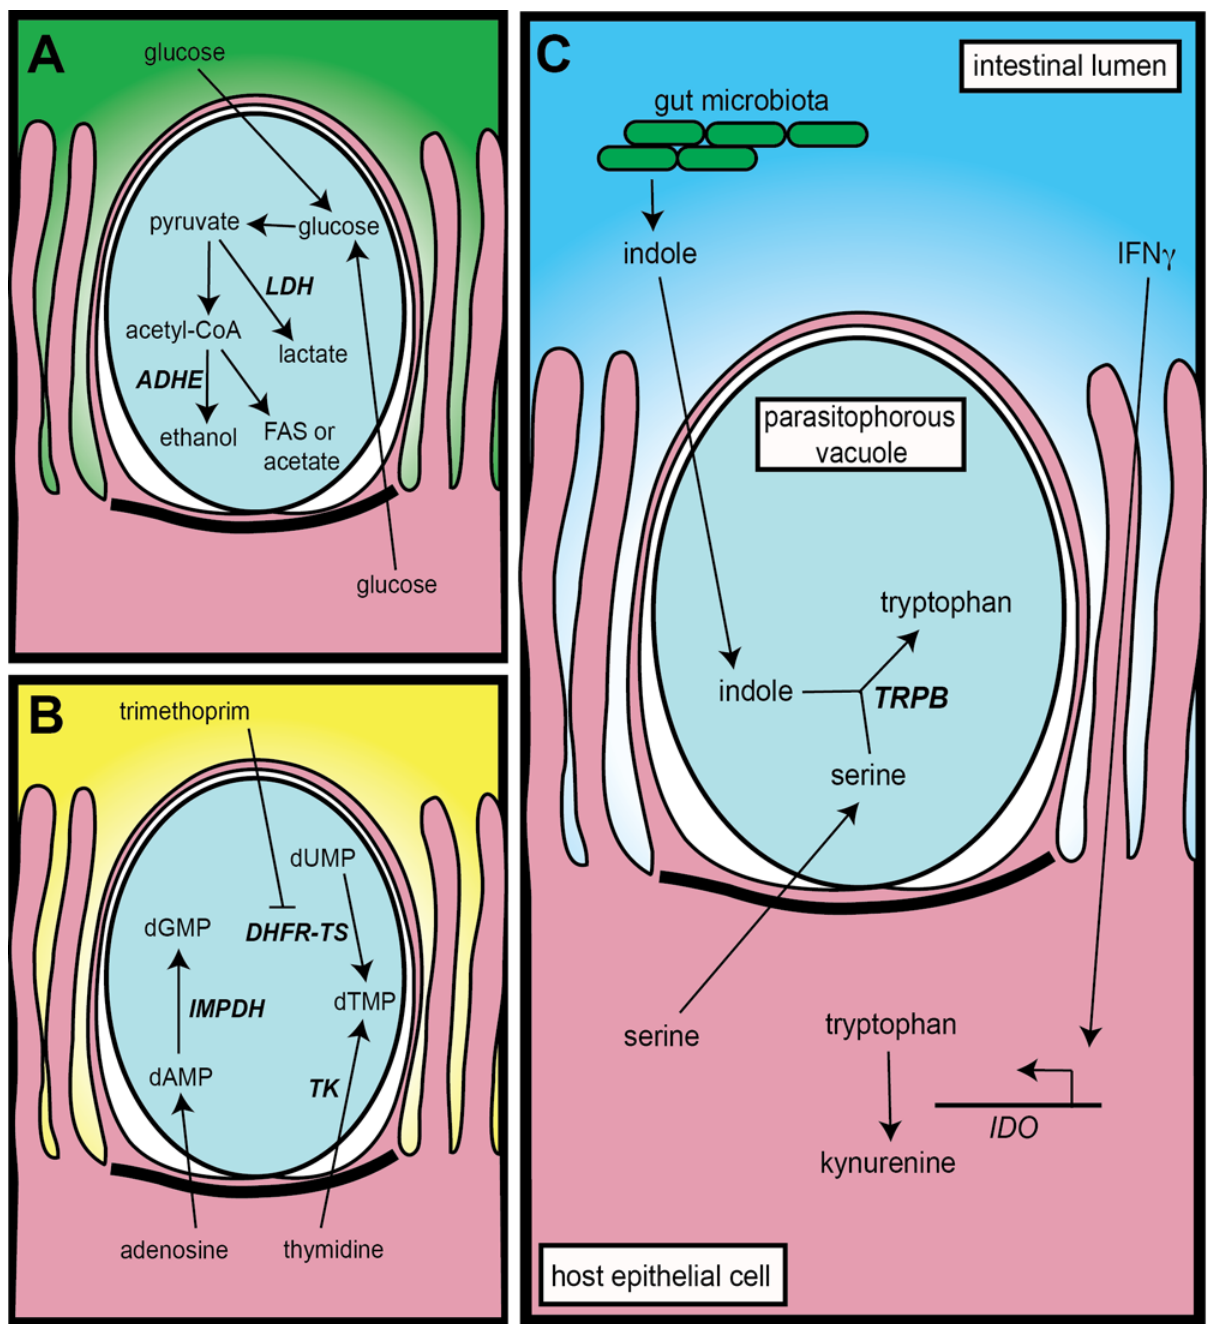
Fig 1. Horizontally transferred genes and their proposed functions in Cryptosporidium biology. A. Anaerobic metabolism . Cryptosporidium can regenerate oxidized NAD either directly from pyruvate via lactate dehydrogenase (LDH, cgd7_480 ) or from acetyl-CoA via a bifunctional alcohol dehydrogenase (ADHE, cgd8_1720 ). B. Nucleotide salvage. Cryptosporidium relies on inosine 5 0 monophosphate dehydrogenase (IMPDH) to convert deoxyadenosine monophosphate (dAMP) to guanosine monophosphate (dGMP) within the parasitophorous vacuole. Dihydrofolate reductase-thymidylate synthase (DHFR-TS, cgd4_4460 ) and thymidine kinase (TK, cgd5_4440 ) can both produce deoxythymidine monophospohate (dTMP); however, the presence of TK allows Cryptosporidium to survive treatment with dihydrofolate reductase (DHFR) inhibitors such as pyrimethamine and trimethoprim. C. Immune evasion. Interferon gamma (IFN γ ) induces the production of indoleamine 2,3-deoxygenase (IDO) within infected host cells, which converts host tryptophan to kynurenine and starves intracellular organisms. Cryptosporidium has a horizontally acquired tryptophan synthase B (TrpB, cgd5_4560 ), possibly to evade this starvation. TrpB is capable of synthesizing tryptophan from exogenous serine and indole produced by gut